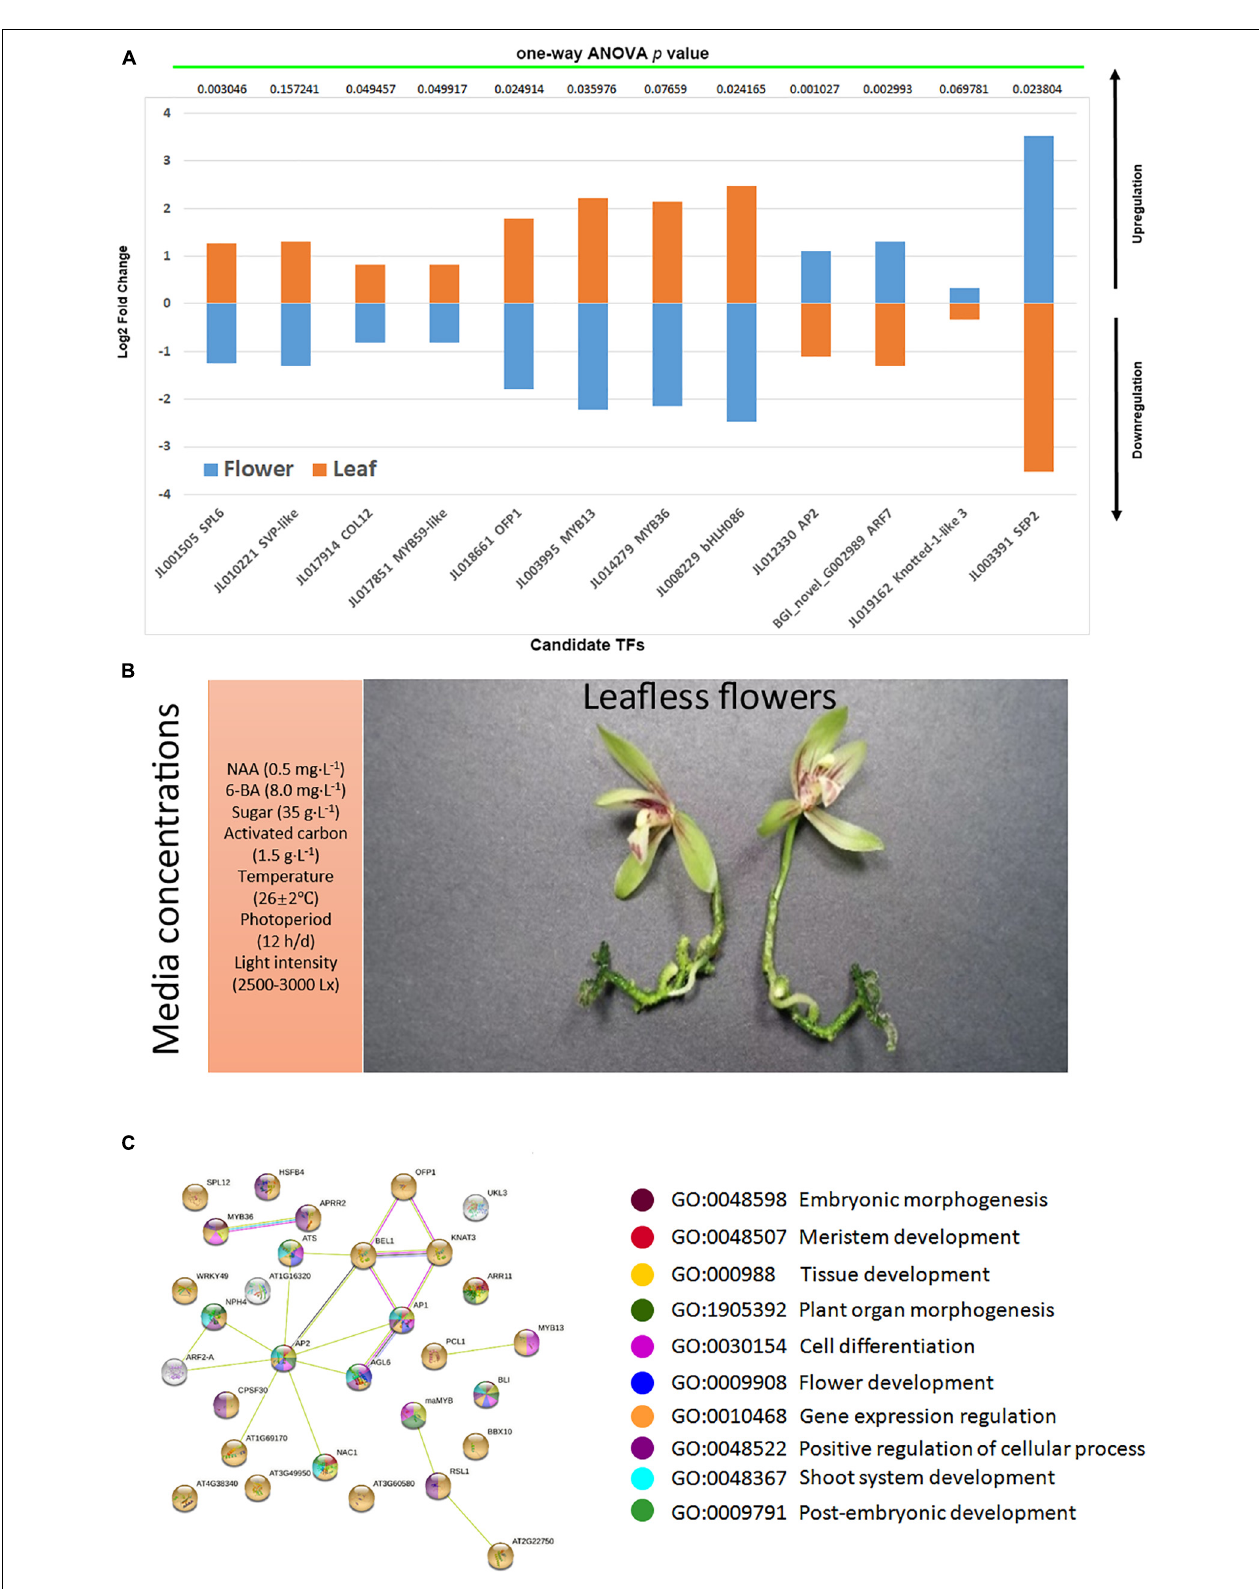
FIGURE 8 | The validation of selected candidate TFs (A) ; the abnormal flowering along with media compositions (B) ; the string-based interaction network for the regulation of flowering (C) , the ball colors represent biological process enrichment.